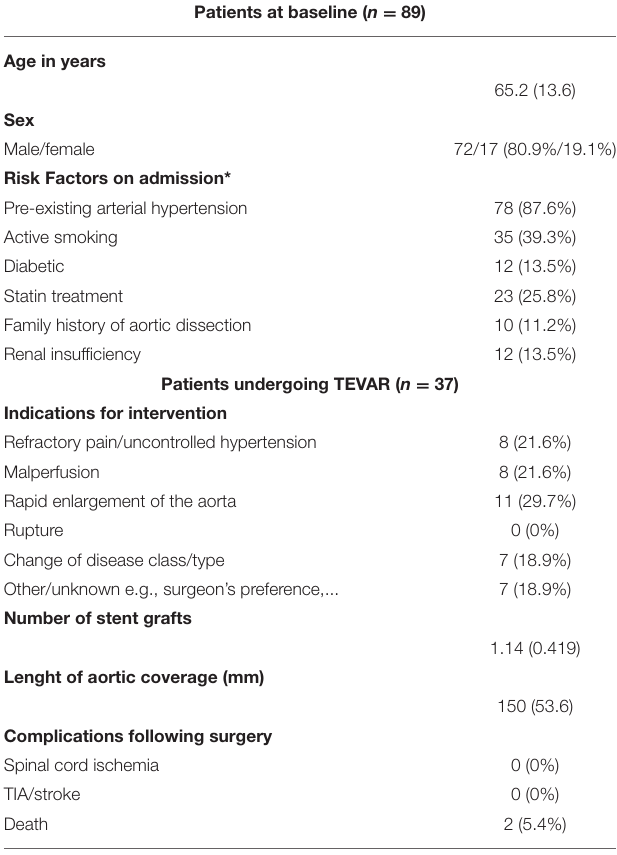
TABLE 1 | Age, sex and risk factors on admission are displayed for all patients at